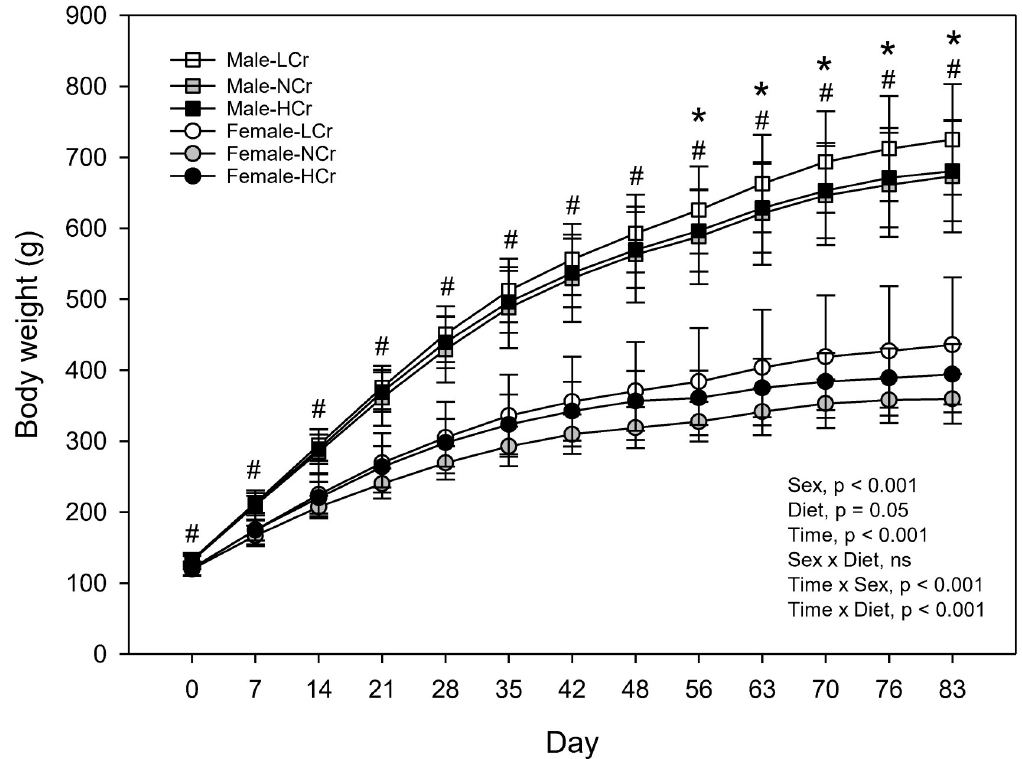
Fig 1. Body weights of male and female rats. Results are presented as means ± SD, n = 9 − 10. Results were analyzed by mixed- design ANOVA to determine effects and interactions of time, sex and diet. Time × sex and time × diet interactions (p < 0.001) were observed. Univariate results are shown for each time point for effect of sex ( # , p < 0.001). For effect of diet, results of males and females were pooled and the LCr group differed from the NCr group by Dunnett’s test ( � , p < 0.01). ns, p � 0.05.